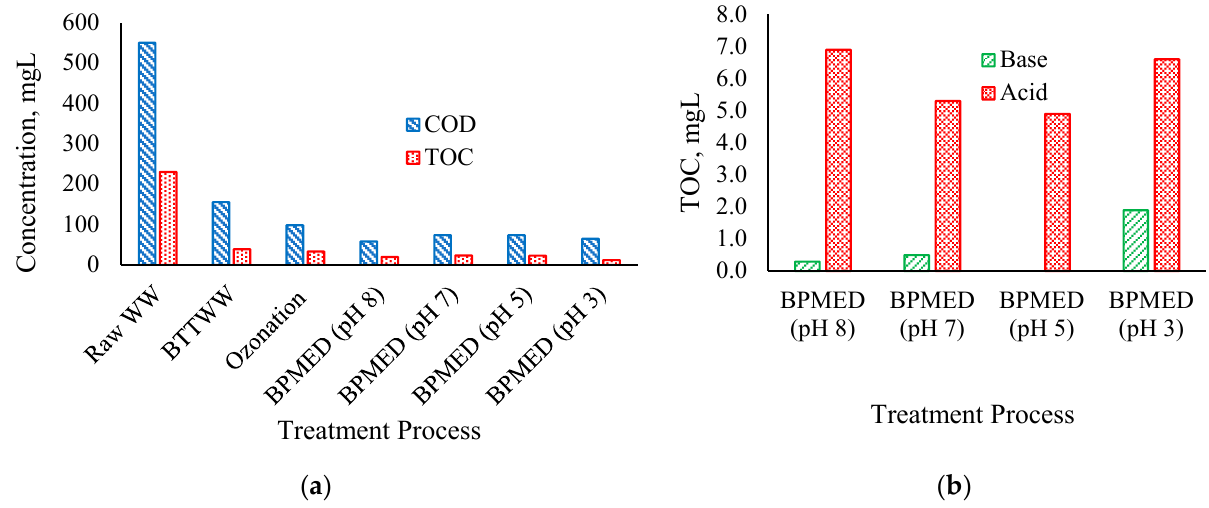
Figure 7. COD and TOC concentrations after each treatment process ( a ), TOC concentrations of acid and base compartments ( b ).